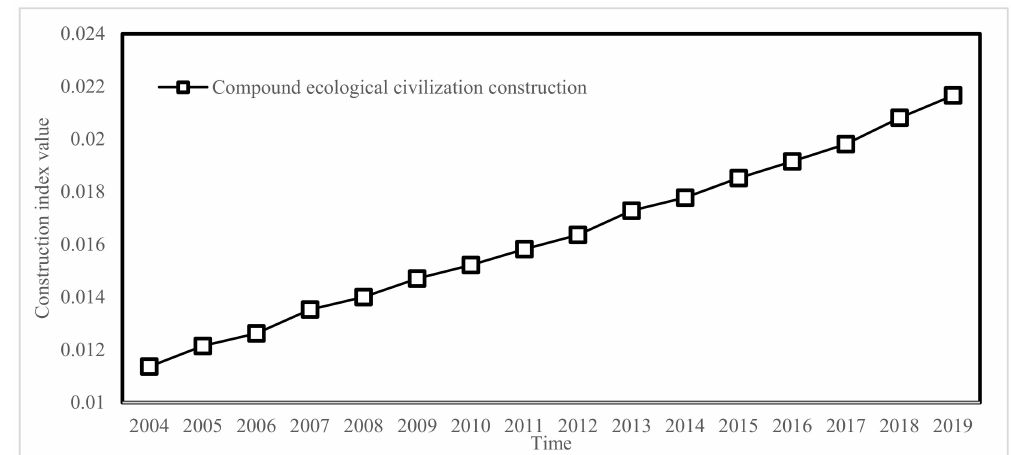
Figure 2. Compound ecological civilization construction index from 2004 to 2019.